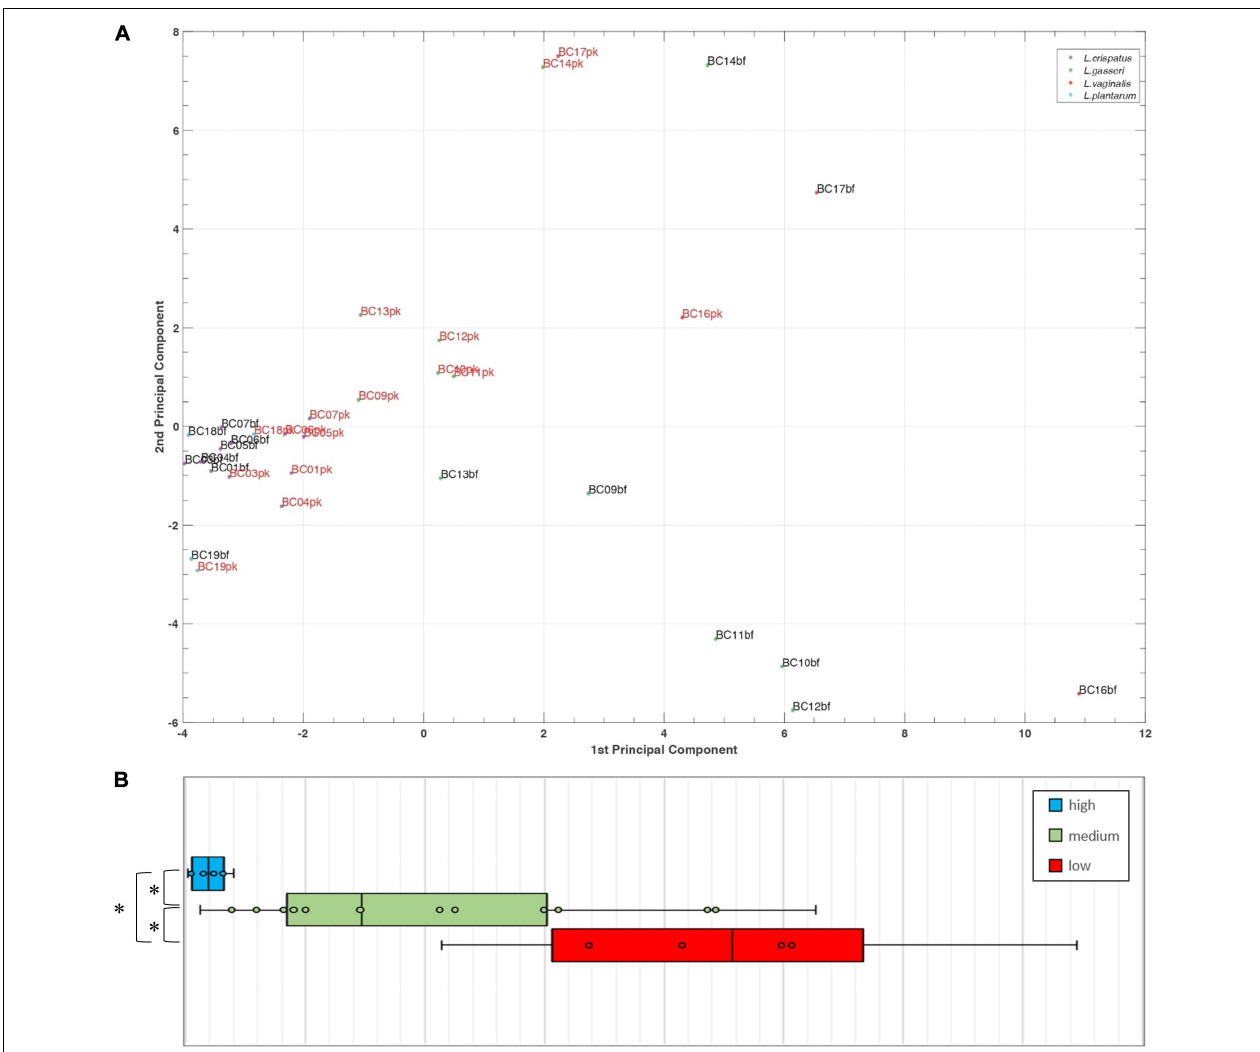
FIGURE 6 | (A) Biplot of a PCA performed on Lactobacillus bf-CFS and pk-CFS metabolome and anti- Candida activity data. (B) Boxplot of CFS distribution on PC1 based on anti- Candida activity score. Lines within the boxes indicate the median values of the samples. Each box represents the interquartile range (25–75th percentile). The extremes of the bars indicate the 10th and 90th percentiles,